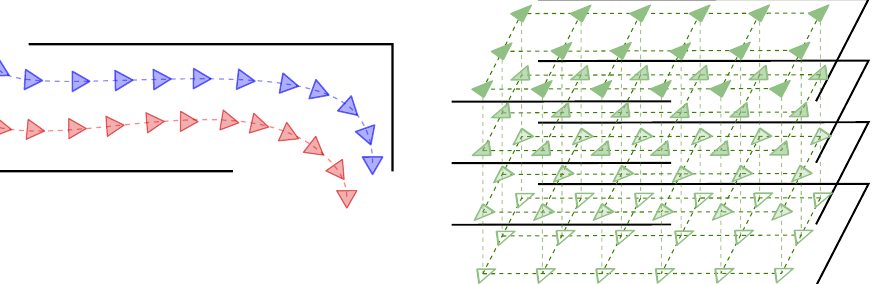
Figure 2. Each PSAC is constructed from descriptor–pose pairs that can be obtained from two different robot trajectories (left, blue and red) or a grid of poses (right, green). This is better seen in